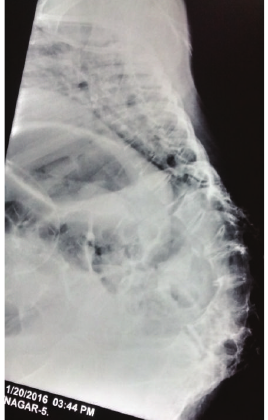
Figure 3: X-ray of spine showing kyphosis in lumbar region and lordosis in thoracic